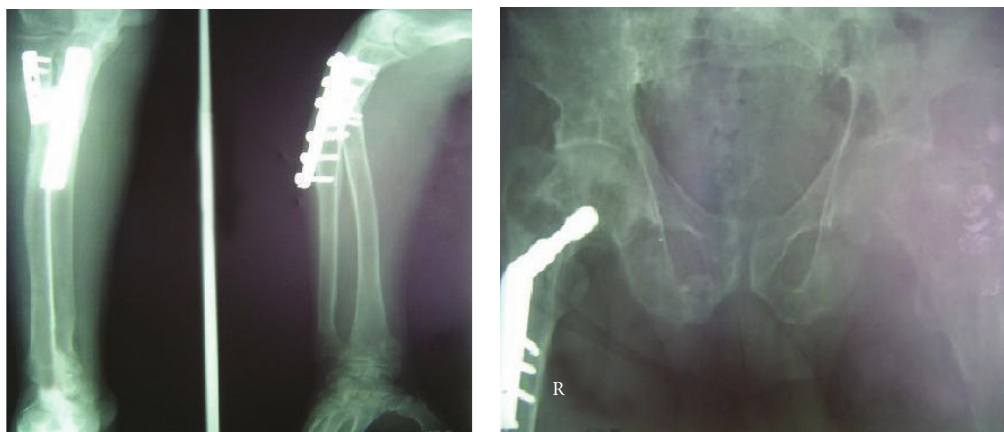
Figure 1: The fractures that were treated by open reduction and internal fixation.